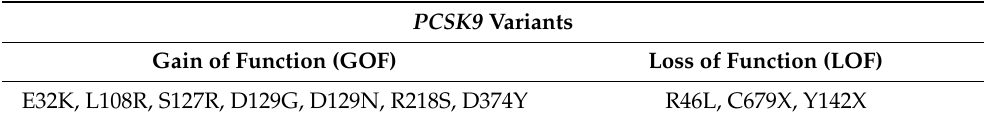
Table 2. Most frequent naturally occurring PCSK9 mutations